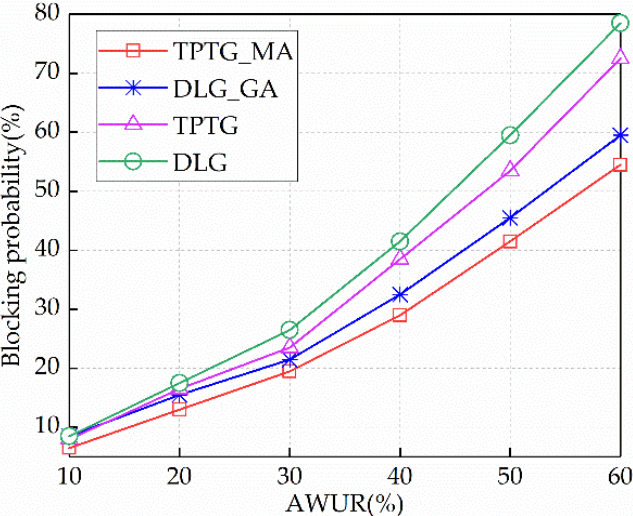
Figure 7. Comparison of the blocking probability between the DLG, TPTG, DLG_GA, and TPTG_MA.